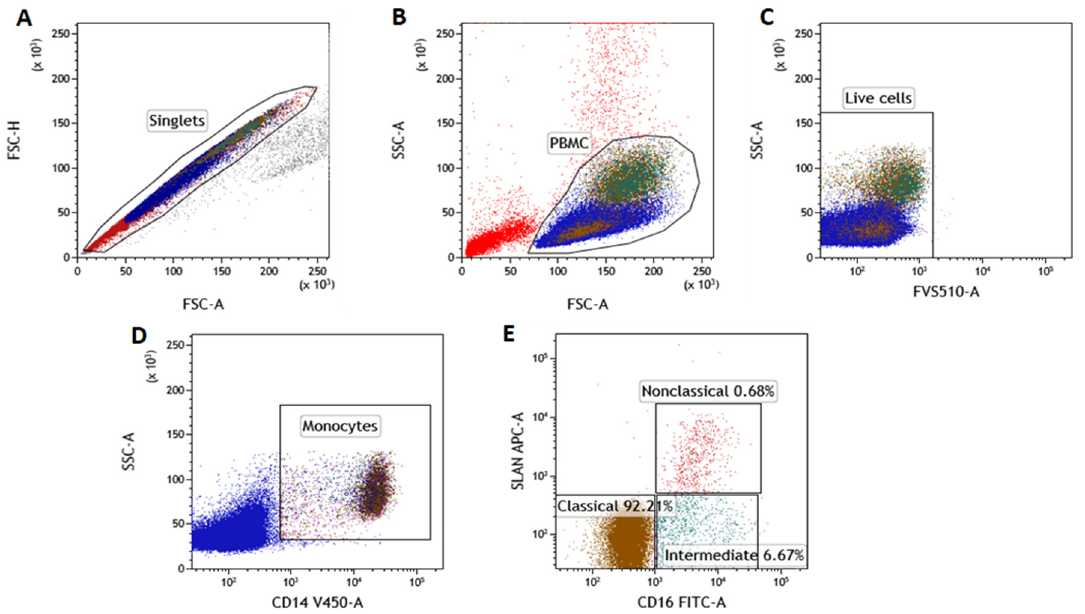
Figure 1. An example of the cytometric evaluation of SLAN-positive and SLAN-negative monocytes’ subpopulations from a CLL patient. ( A ) FSC-H vs. FSC-A dot plot of the doublets’ elimination (setting up gate covering the singlets population); ( B ) dot plots of SSC-A vs. FSC-A gating of PBMC cells; ( C ) dot-plot of the FVS510 vs. SSC exclusion of dead cells from further analysis. Live cells collected in the LIVE CELLS gate were used for further evaluation. ( D ) From the living cells, CD14 + cells (dot plot: SSC vs. CD14 V450; gating of Monocytes) were identified. The presence of the CD14 marker and scatter properties were the basis for the identification of monocytes. ( E ) SLAN APC vs. CD16 FITC dot plot—the differentiated expression of CD16 and SLAN molecules allowed the identification of classical (CD14 + CD16 − SLAN − ), intermediate (CD14 + CD16 + SLAN − ) and non-classical (CD14 dim CD16 + SLAN + ) monocytes.